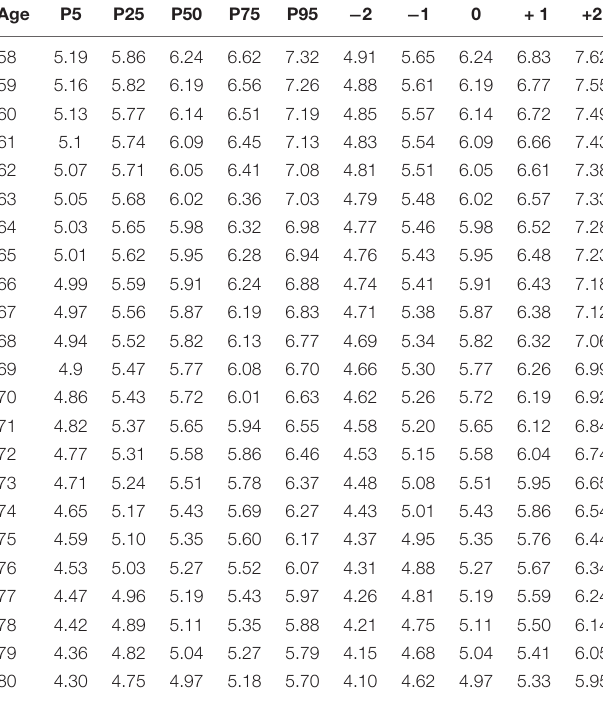
Female: In the final multivariable model, the relationship between phase angle and age was associated with BMI and family income (with a significant interaction) ( Supplementary Table 1 ). Male: In the final multivariable model, the relationship between phase angle and age was associated with BMI and skin color (with a significant interaction) ( Supplementary Table 1